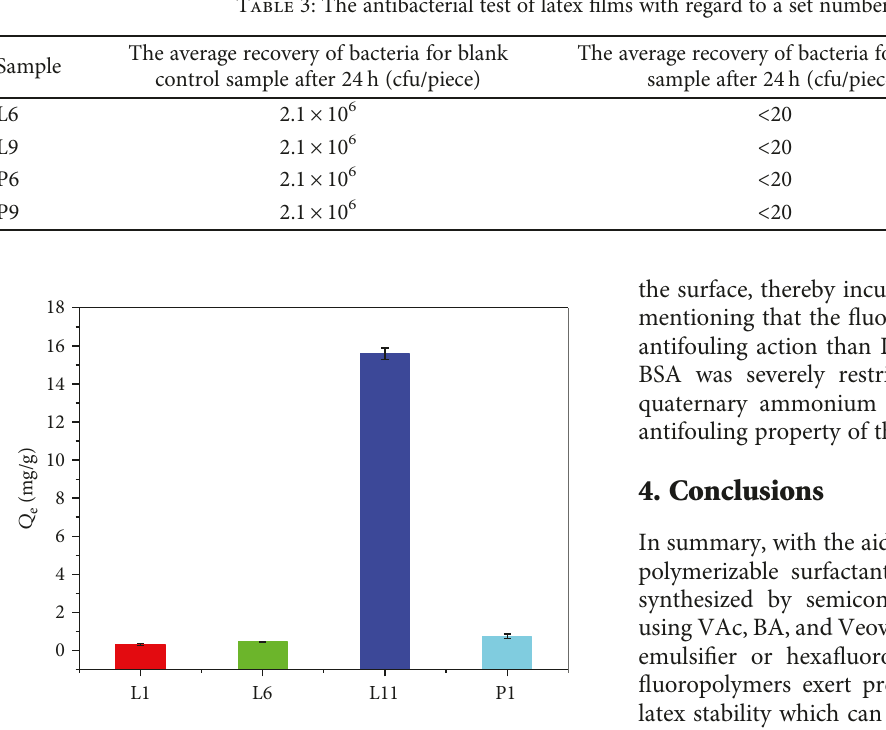
Figure 5: Comparison of the lysozyme adsorption levels of L1, L6, L11, and P1.